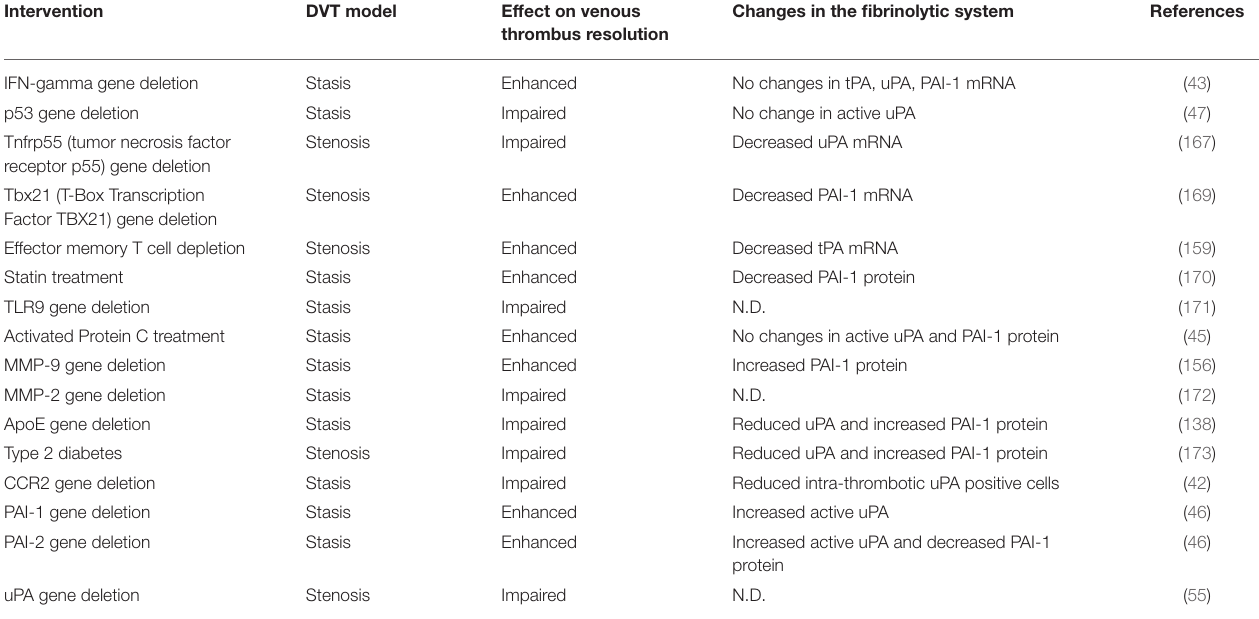
TABLE 1 | Effect of interventions in mouse models of deep vein thrombosis on thrombus resolution.